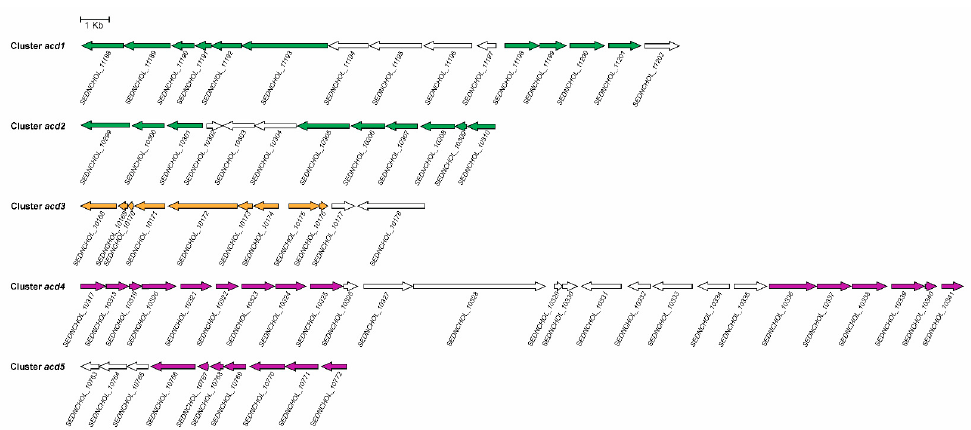
Figure 11. Genetic organisation of the genes encoding 2,3- seco pathway functions for cholesterol degradation in Sterolibacterium denitrificans